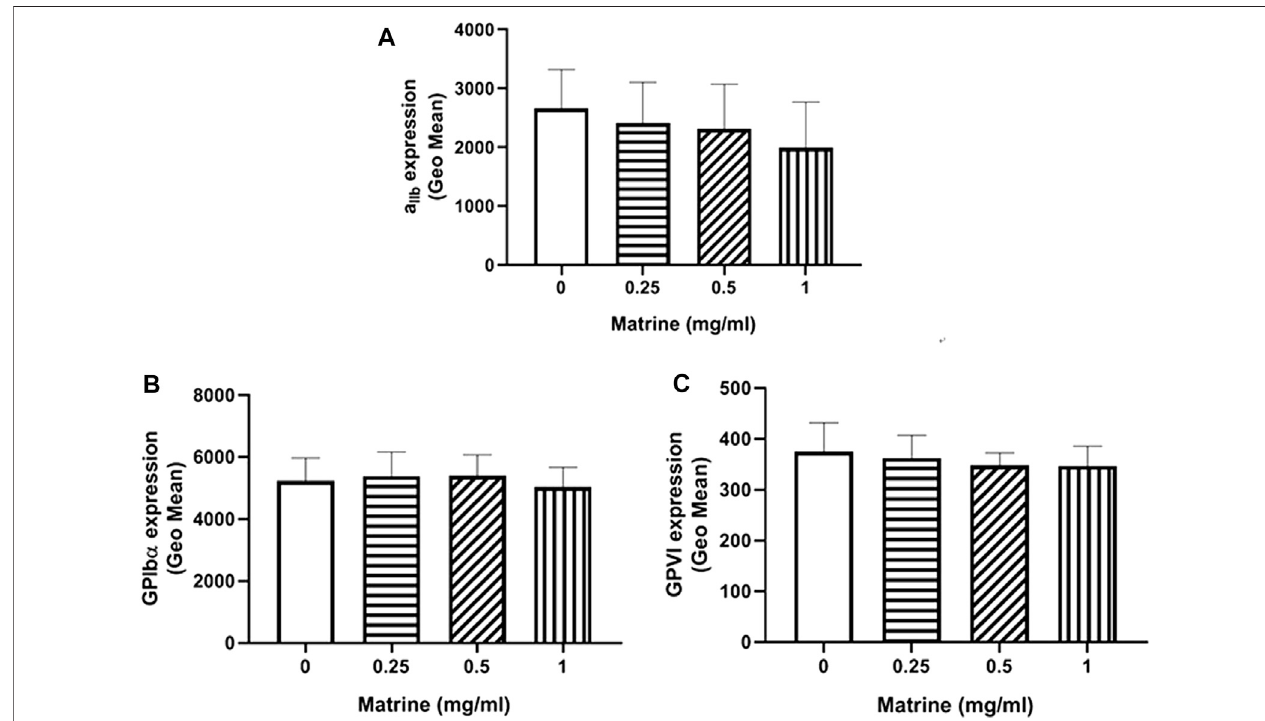
FIGURE 2 | Surface expression level of platelet membrane receptors. After matrine treatment, the expression of platelet receptors α IIb β 3 (A) , GPIb α (B) and GPVI (C) was detected by fl ow cytometry. Data were presented as mean ± SE ( n (cid:2) 6 – 7) and analyzed by one-way ANOVA.